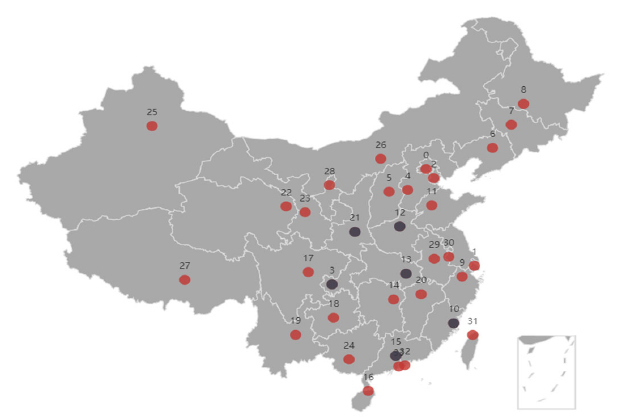
Fig. 3. The distribution of demand nodes and candidate